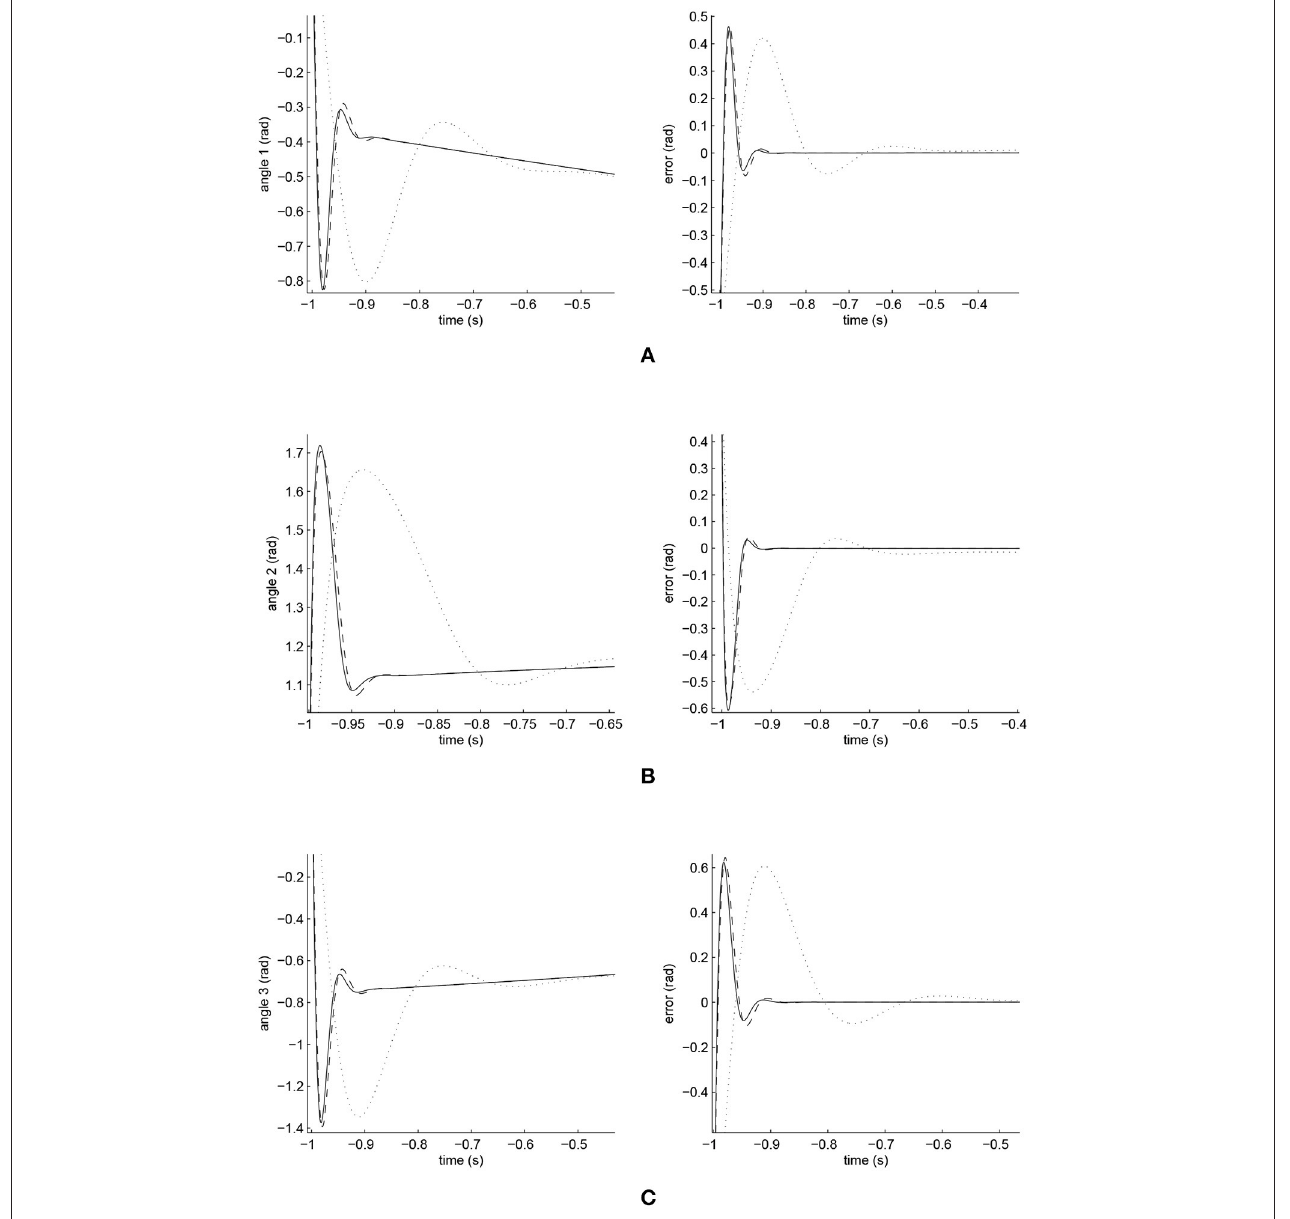
FIGURE 11 | Amplified trajectory responses (in the left) and tracking errors (in the right) of Joints 1, 2, and 3. The solid line indicates the performance of the iFBEL; the dotted line represents that of the PID controller; and the dot dash line implies that of the FCMAC controller. (A) Amplified trajectory response and tracking error of Joint 1. (B) Amplified trajectory response and tracking error of Joint 2. (C) Amplified trajectory response and tracking error of Joint 3.